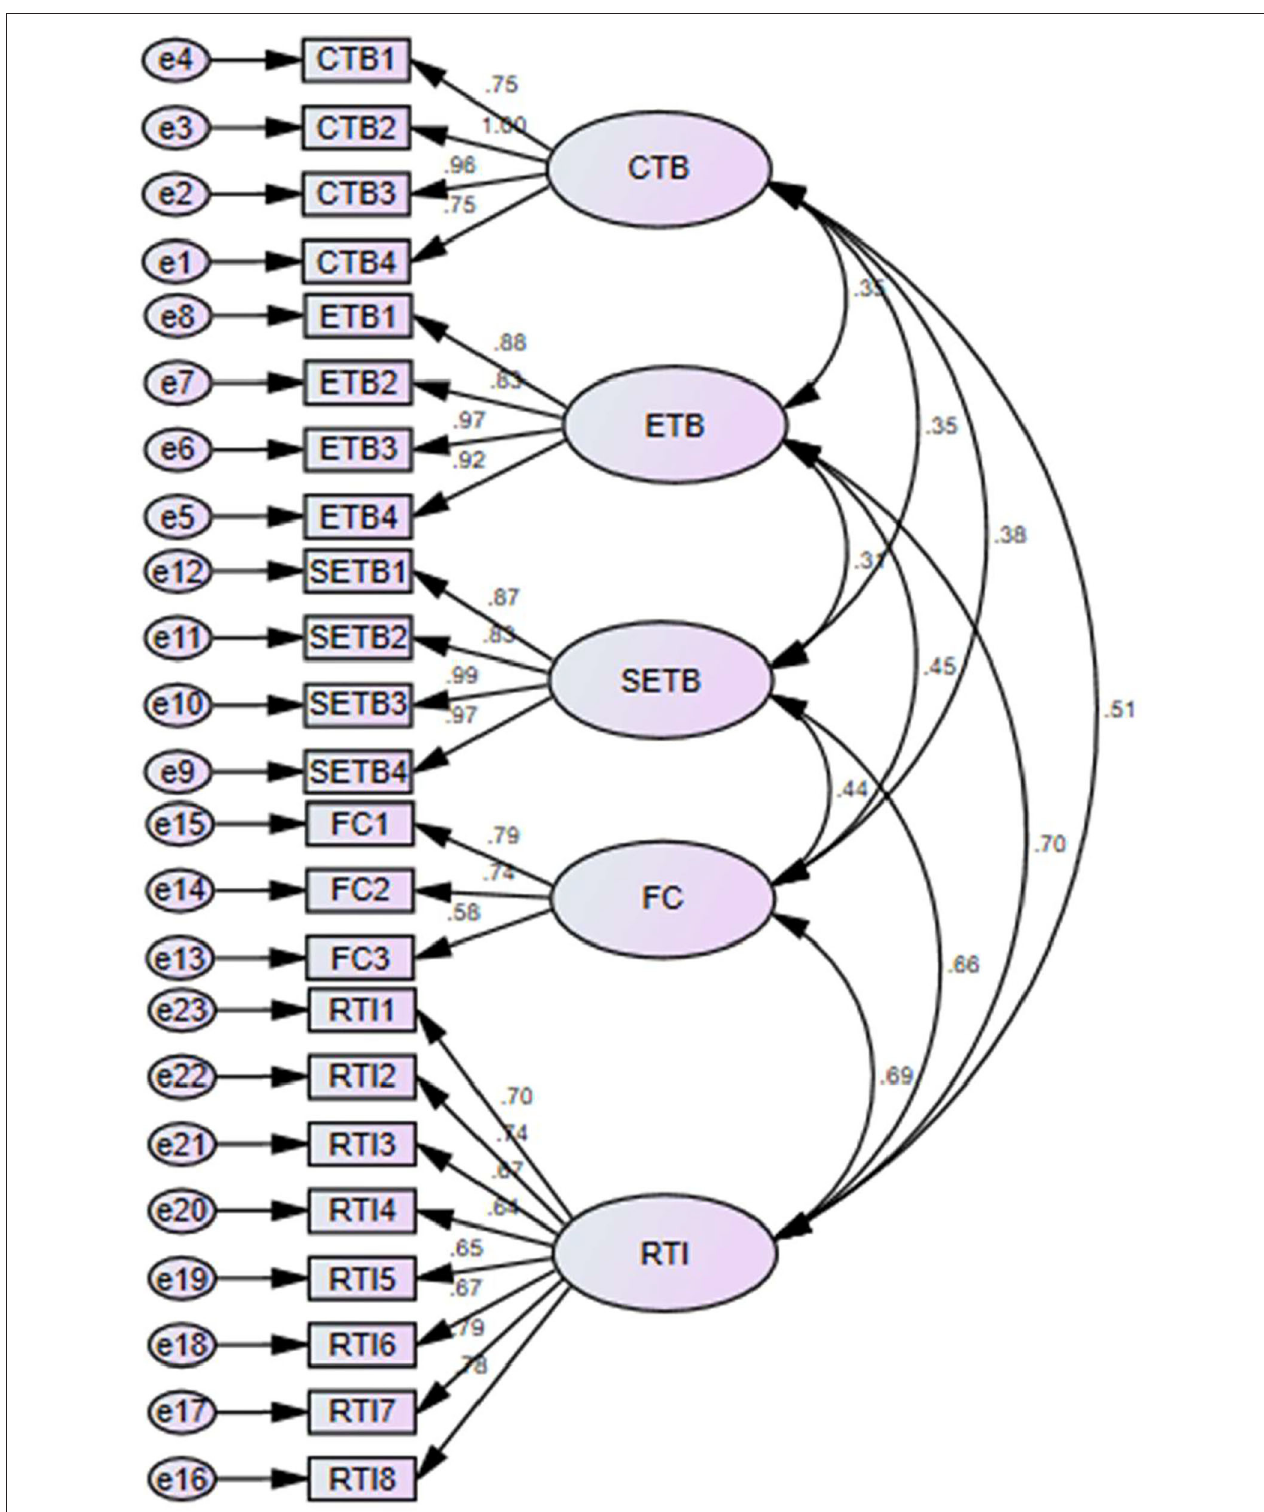
FIGURE 3 | Measurement model